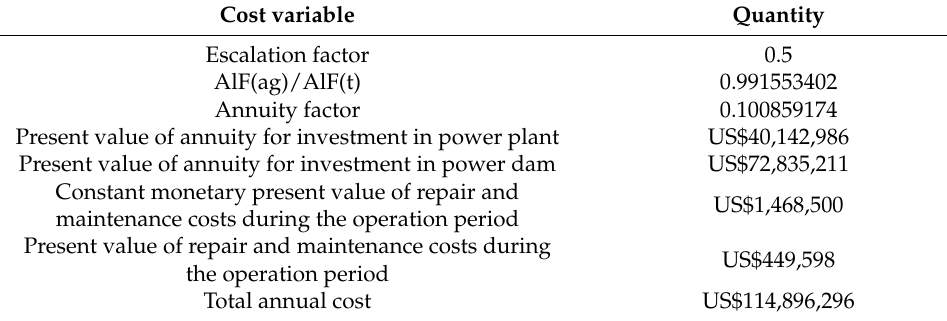
Table 3. Cost of power generation estimated by HECAM II Model in Bakhtiari Dam.